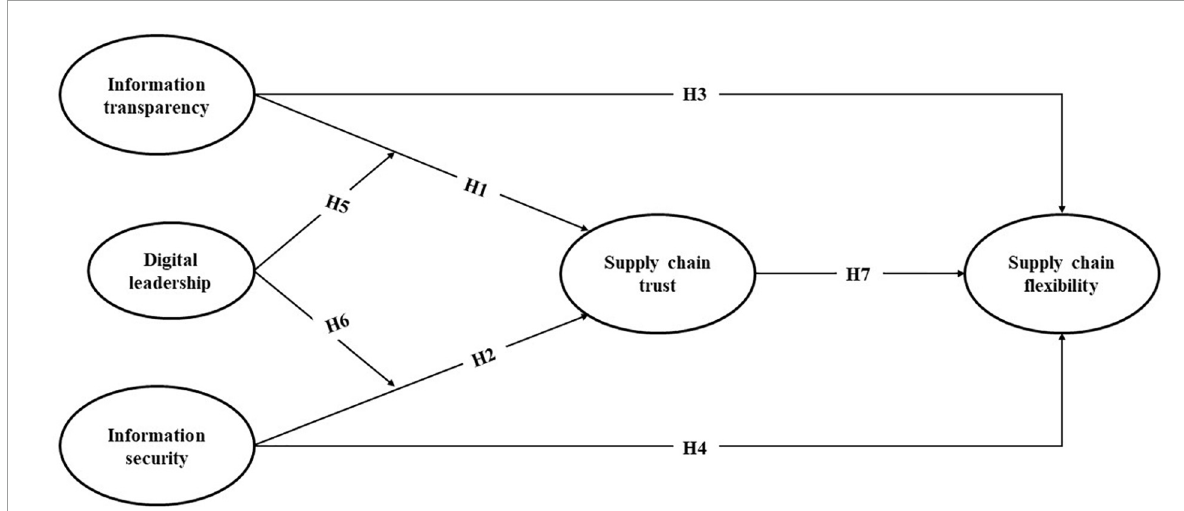
FIGURE2 Estimated results from structural equation modeling. N , 338. *** p < 0.001, ** p < 0.01, * p <